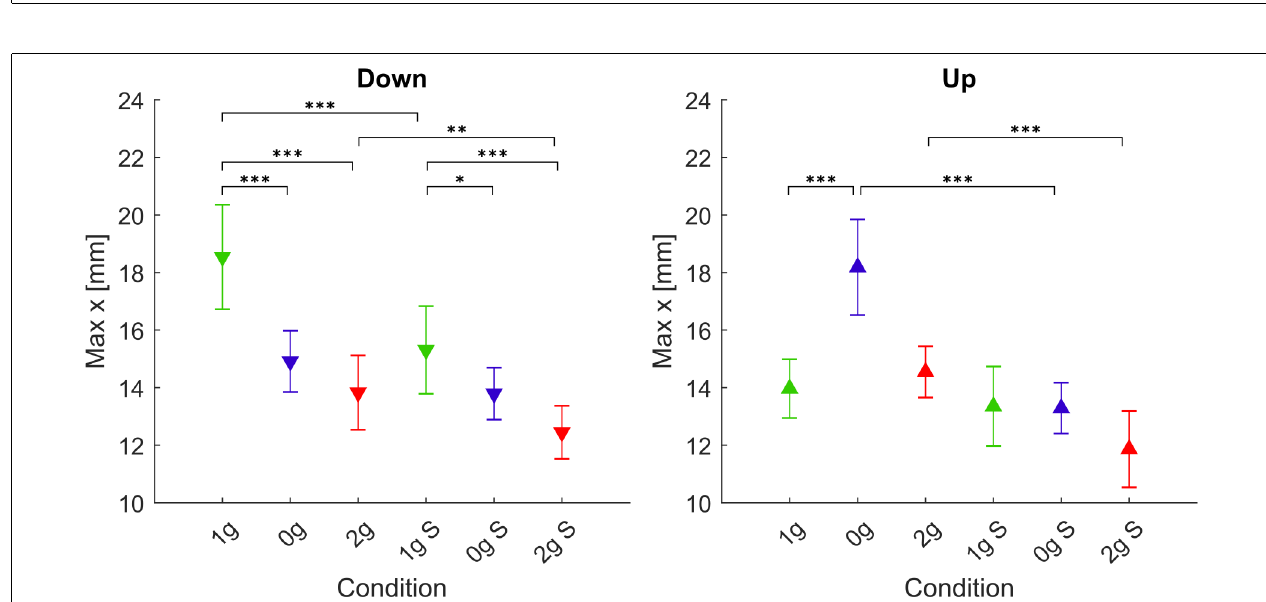
FIGURE 7 | Maximum displacement in the x direction. Downward-pointing triangles denote mean values for downward movements, upward-pointing triangles denote mean values for upward movements, the whiskers denote the standard error of the mean. Green represents normogravity, blue represents microgravity and red represents hypergravity conditions, (1g, 0g, 2g) denote in-flight gravitational conditions, (1g S, 0g S, 2g S) denote simulated gravitational conditions. ∗ p < 0.05, ∗∗ p < 0.01, ∗∗∗ p <